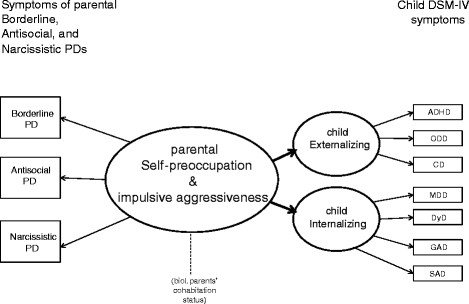
Hypothesized model.